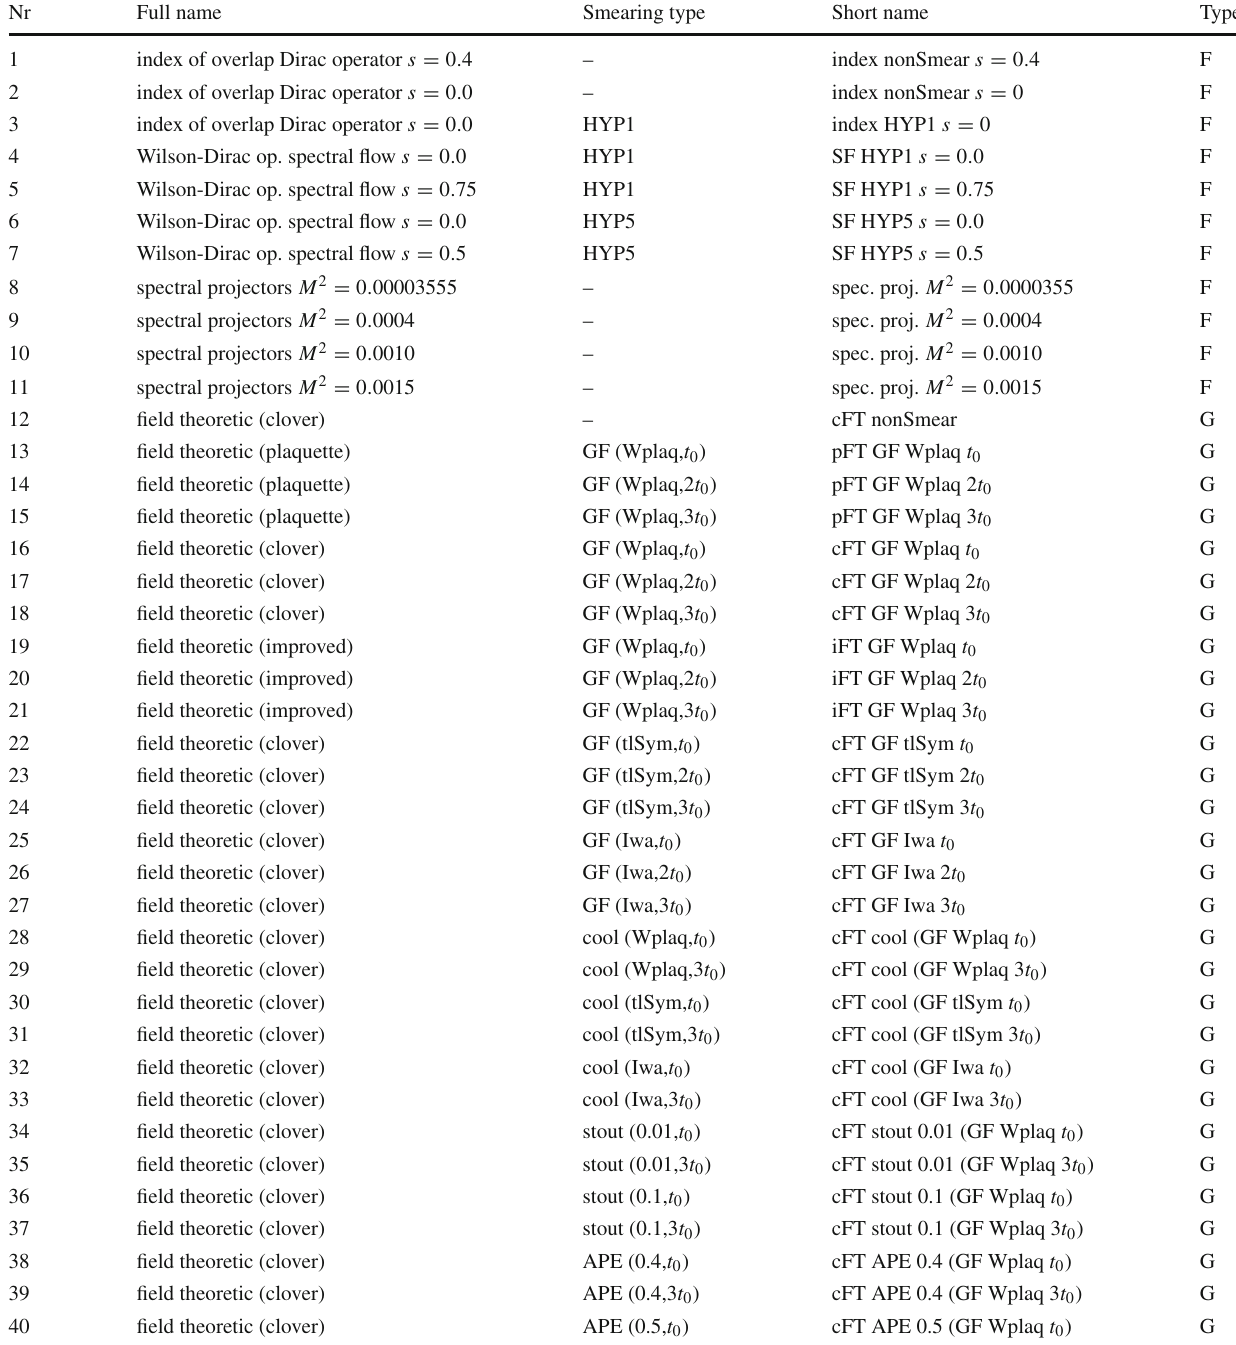
Table 2 The relevant characteristics of each topological charge defini- tion. For each definition, we give a number, full name, type of smear- ing of gauge fields (– = no smearing, HYP n = n iterations of HYP smearing, GF (action, t ) = gradient flow with a given smoothing action (Wplaq = Wilson plaquette, tlSym = tree-level Symanzik improved, Iwa = Iwasaki) and at flow time t , cool (action, t ) = cooling (smoothing action as for GF) and a number of steps corresponding to GF at flow